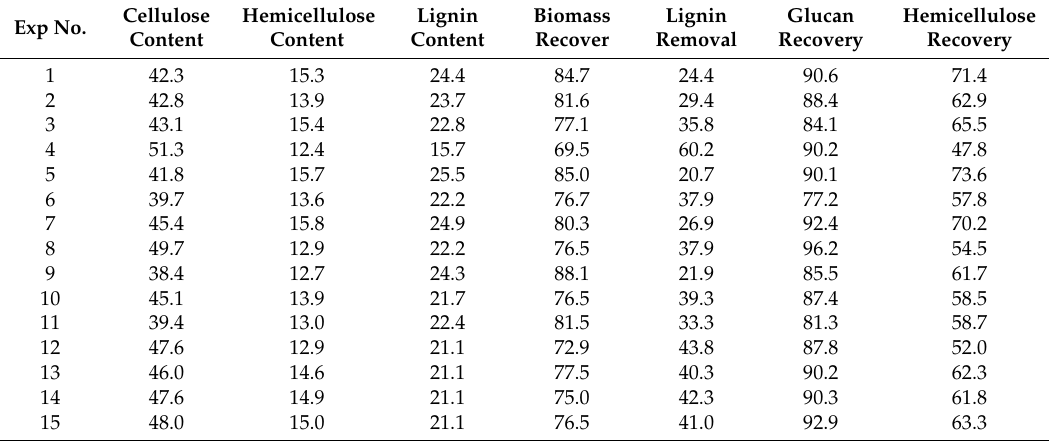
Table 4. Changes in the biomass content [%] occurring during alkaline pre-treatment. Exp